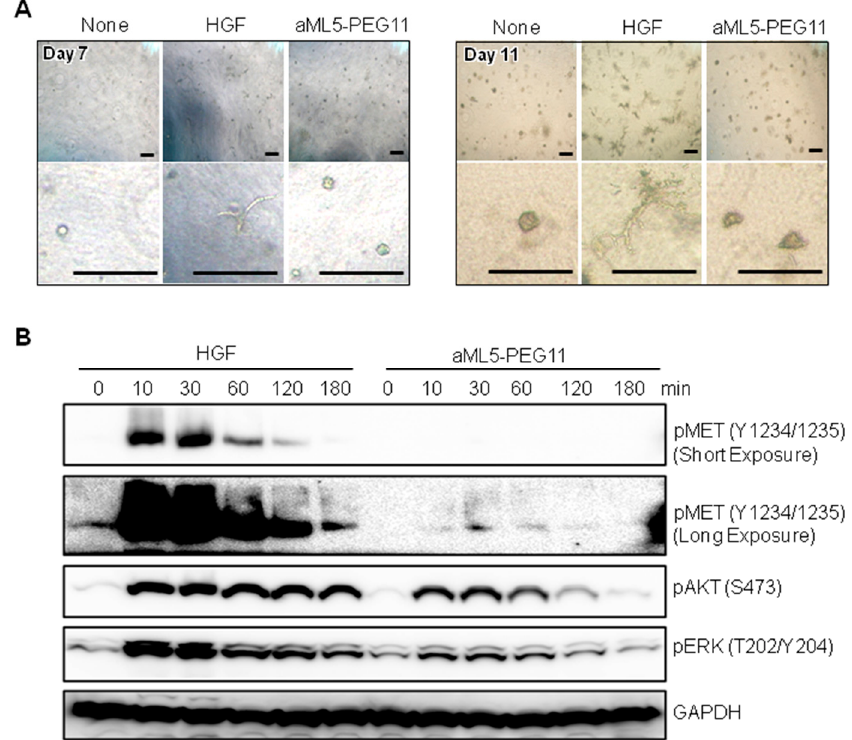
Figure 5. Characterization of morphogenic responses in 3-D collagen gel. ( A ) Changes in appearance of HuCCT1 cells growing in collagen gel matrix. HuCCT1 cells encapsulated in collagen gels were cultured in the absence or presence of 100 nM aML5-PEG11 or 3.3 nM HGF for 11 days. Photographs were taken on day 7 and day 11. Scale bars: 400 µ m. ( B ) Time-dependent changes in MET, AKT, and ERK phosphorylation. HuCCT1 cells were untreated or treated with 100 nM aML5-PEG11 or 3.3 nM HGF. MET, AKT, and ERK phosphorylation were evaluated by Western blotting. GAPDH was monitored to ensure equal loading. Each experiment was performed once.